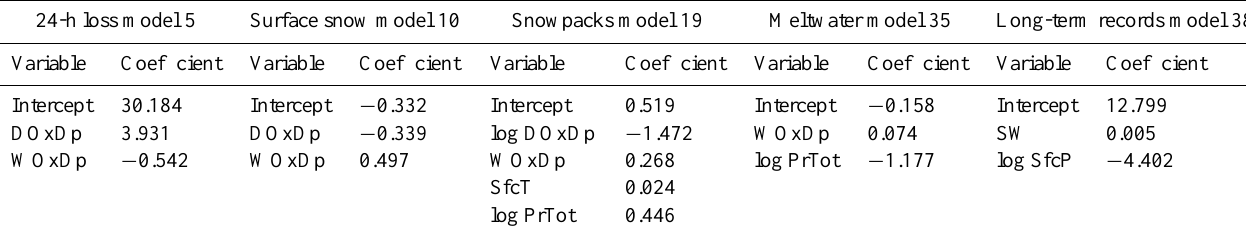
Table 13. Best multiple linear regression models for